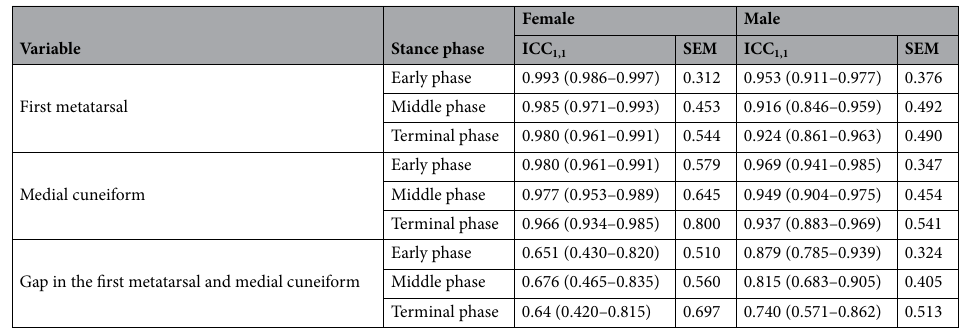
Table 2. Reproducibility of ultrasound vertical movement of the first tarsometatarsal joint during the stance phase of gait. ICC intraclass correlations coefficient, SEM standard error of the measurements. SEM was calculated using the formula s√1-ICC. Values in parentheses are 95% confidence for ICC and lower and upper limits for